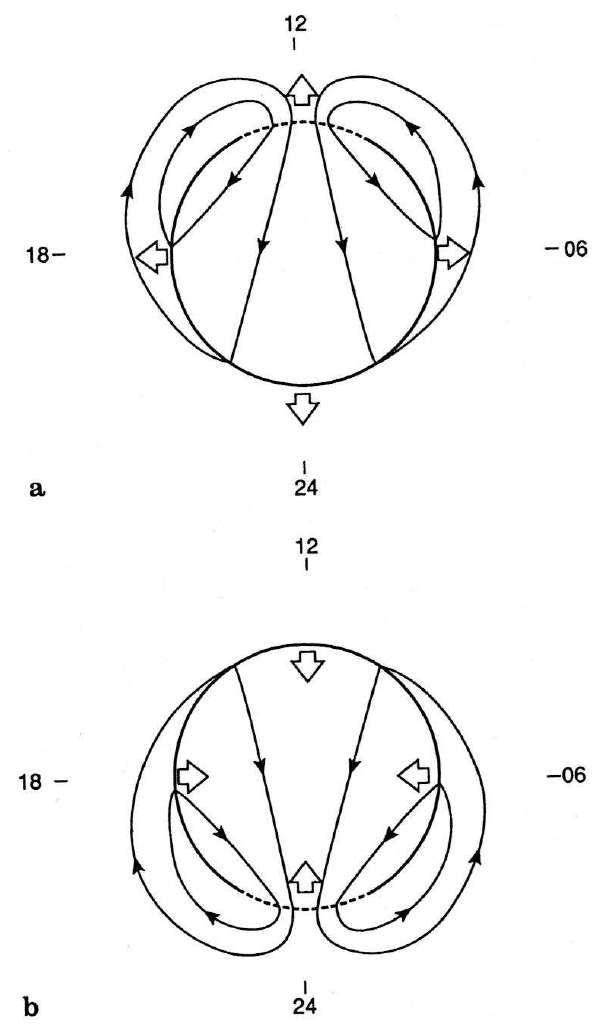
Fig. 13. This sketch, taken from Cowley and Lockwood (1992), illustrates the polar cap convection for (a) dayside reconnection not balanced by concurrent nightside reconnection; (b) tail reconnection without concurrent dayside reconnection. For further details – see Cowley and Lockwood (1992).